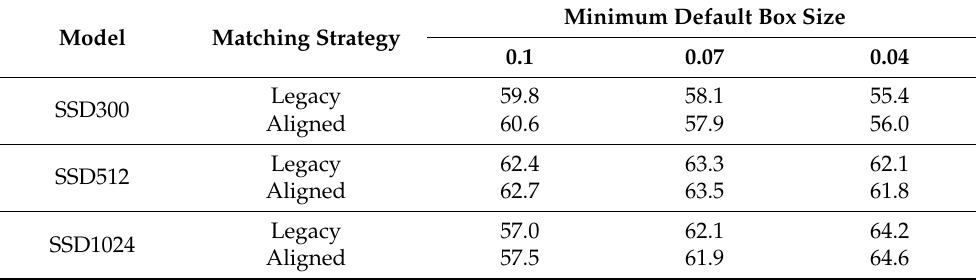
Table 5. Performance on Pascal VOC with various default box